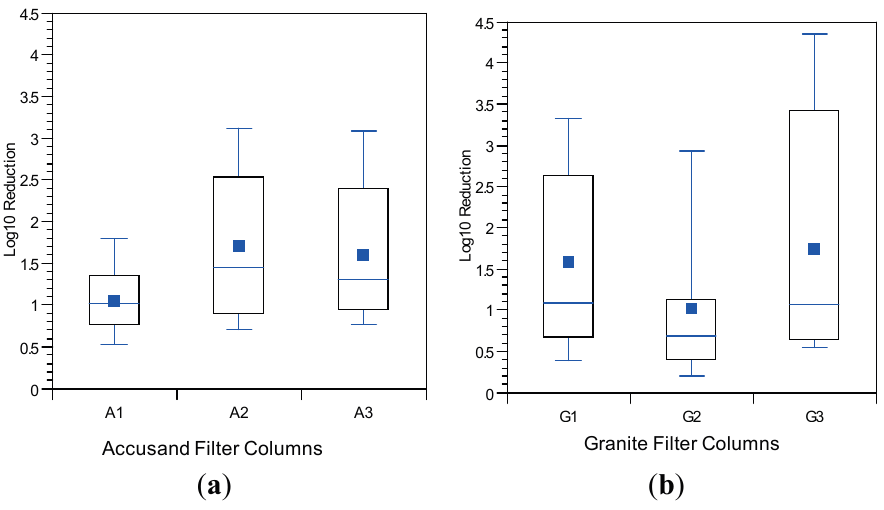
Figure 7. E. coli reductions for ( a ) Accusand-filled columns; and ( b ) granite-filled columns in Column Test No. 2 for samples collected throughout the eight-week experiment. N = 17 for G2; 18 for A1; 19 for A2; 20 for G1, G3 and